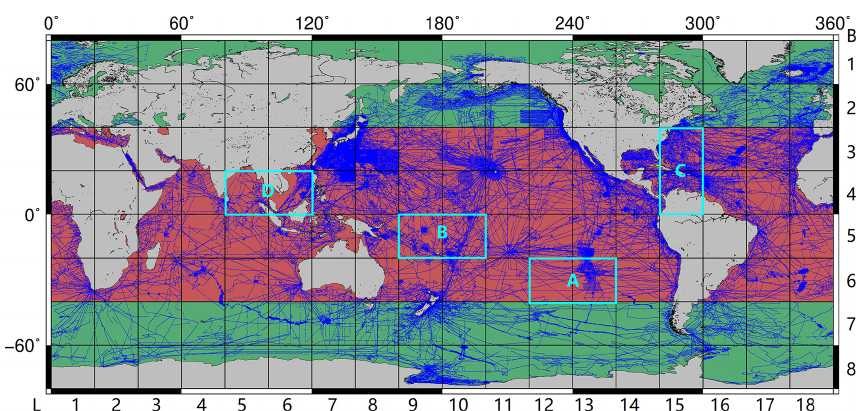
Figure 1. Division map for deriving gravity anomalies and tracks of NCEI (US National Centers for Environmental Information) shipborne data. The red and green areas mean that the reference gravity anomalies are obtained from XGM2019e and EGM2008, respectively. The lines in blue present the cruises of shipborne gravity. The areas in cyan boxes are the special areas for analysis. From 0 to 360 ◦ E, regions are marked from L1 to L18; from 80 ◦ S to 80 ◦ N, regions are marked from B1 to